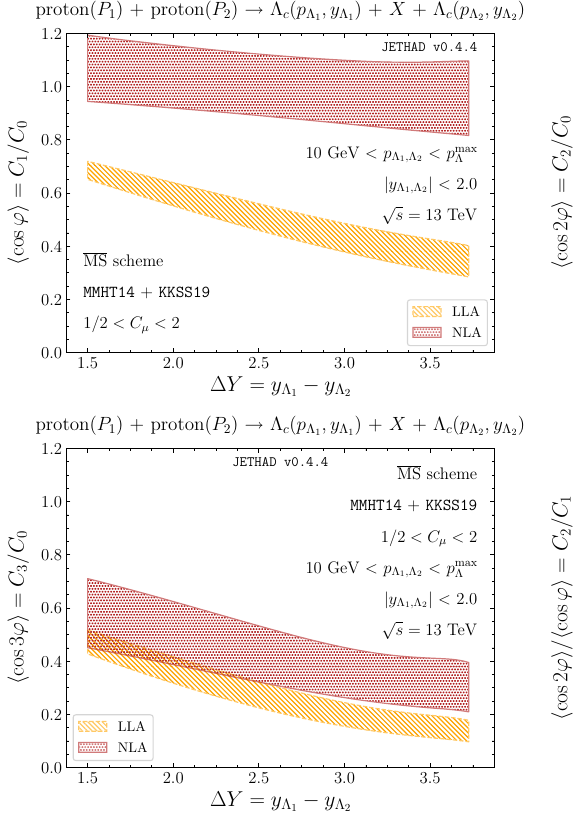
parametersandthe C 0 distributionsareleftalmostunchanged when the lower cutoff for KKSS19 is raised up to the AKK08 one. This feature was expected, since the major contribution to cross section is given by FF longitudinal fractions larger than 10 − 1 (see discussion Section in Ref.